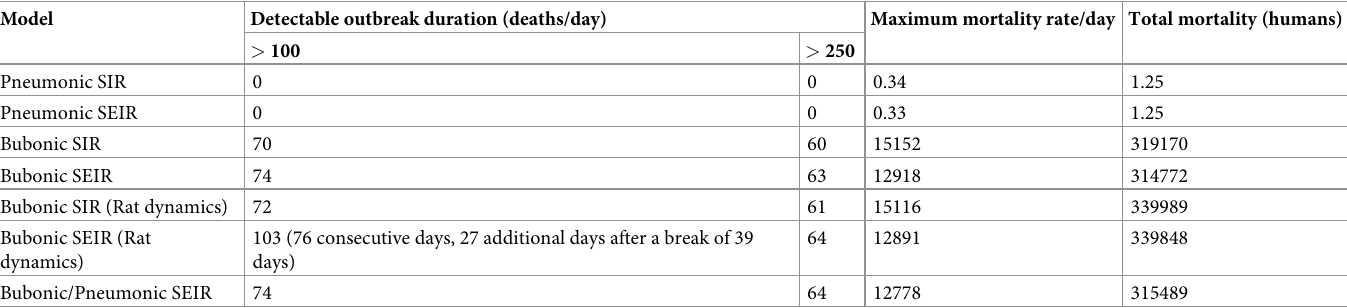
Table 2. Summary of model output for each model type with rat to human ratio of 1:1.